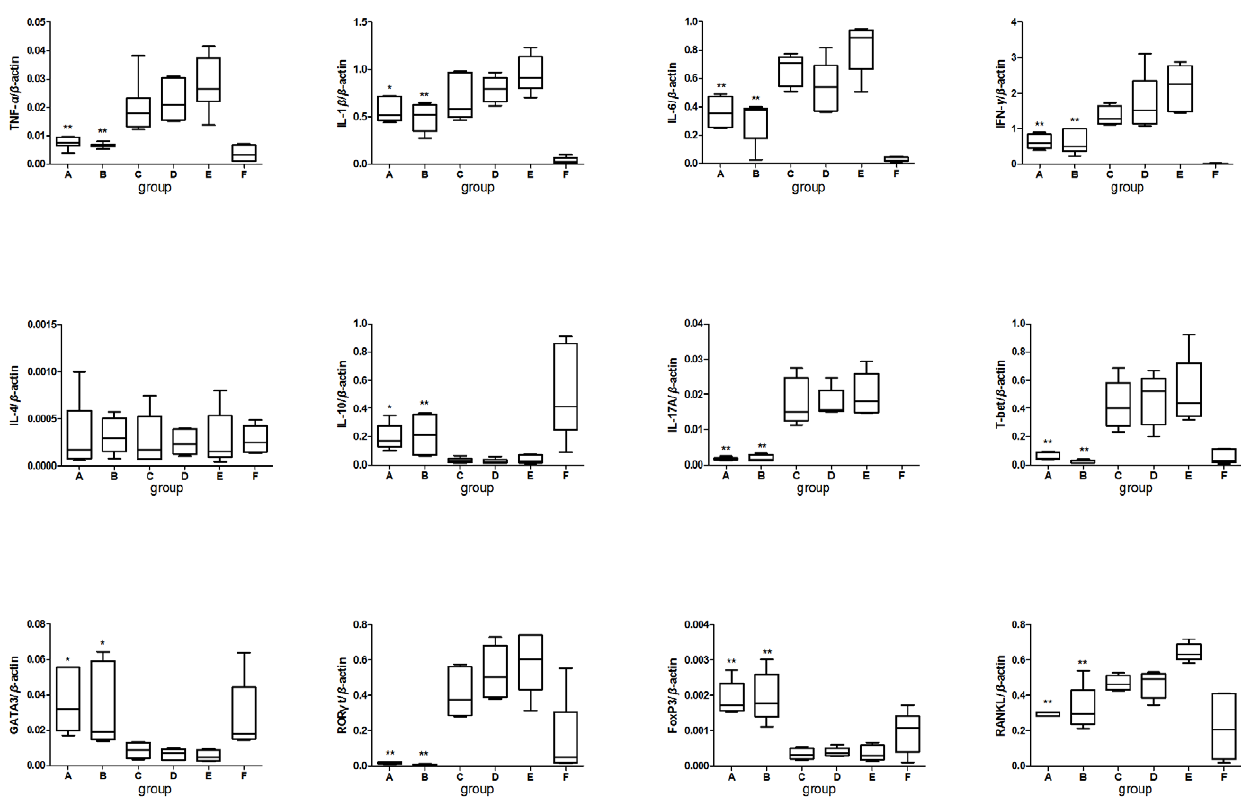
Figure 6. Prior S.japonicum infection reduced the expression of immune mediators in inflammatory joints. Reduced pro-inflammatory cytokines expression in the focal joints in S. japonicum infected mice. The mRNA expression of cytokines and RANKL were quantified by Real time PCR as described in Materials and Methods. Prior S. japonicum infection balanced the pro- and anti-inflammatory cytokines and reduced the expression of RANKL in the local site. Values along the vertical axis represent relative expression levels normalized to b -actin. Compared with CIA control group, *: P , 0.05; **: P , 0.001. Data are representative of three repeated experiments. Abbreviations: RANKL, receptor activator of NF- k B ligand. See Figure 1 for other